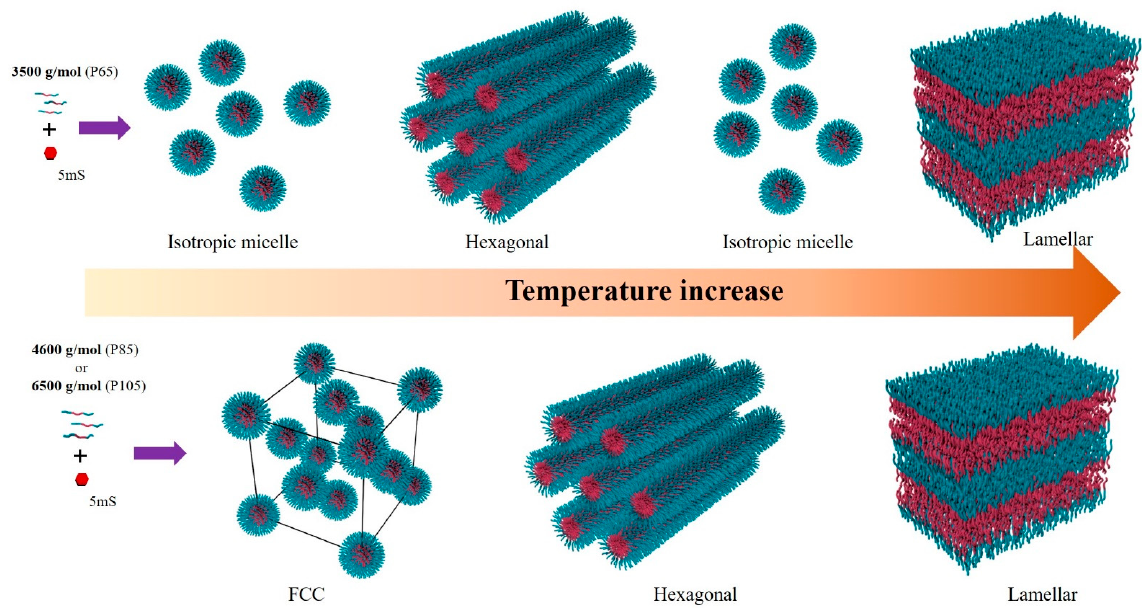
Figure 6. Schematic phase behaviors of Pluronic block copolymer/additive complexes depending on their molecular weight.